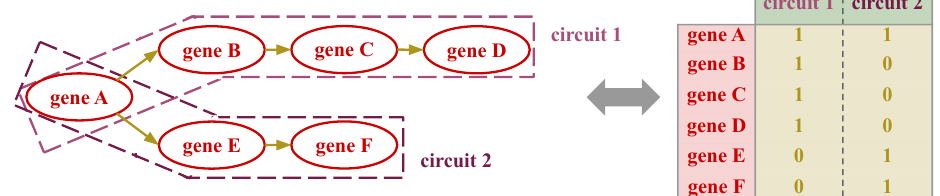
Figure 2. Simplified version on how to decompose a pathway into effector circuits and build the corresponding indicator matrix. On the left side, we see a simplified pathway that gives rise to two effector sub-pathways (referenced as effector circuits in this work), which lead to the indicator matrix depicted on the right